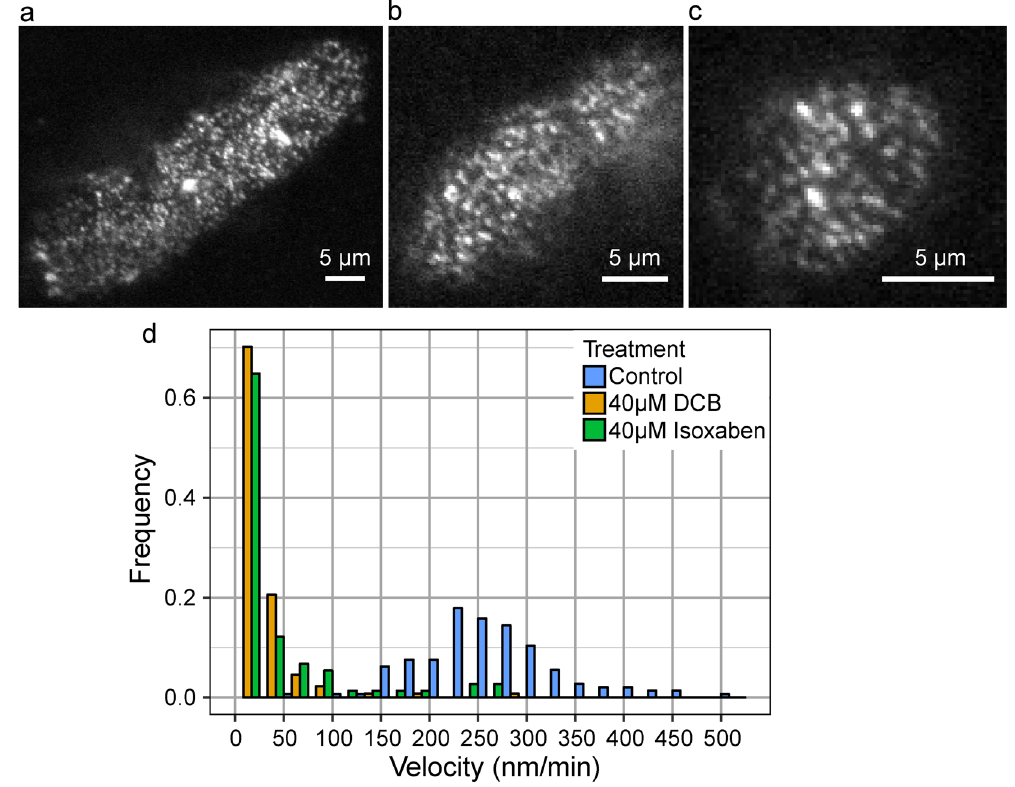
Figure 4. DCB and isoxaben inhibit mEGFP-PpCESA5 particle motility, but do not affect particle density at the cell surface. ( a ) Control protonemal cell treated with 0.1% ethanol. Mean CSC density = 0.48 ± 0.11 particles/ μ m 2 (SD), n = 8 time-lapses. ( b ) Protonemal cell treated with 40 μ M DCB. Mean CSC density = 0.51 ± 0.09 particles/ μ m 2 (SD), n = 8 time-lapses. ( c ) Protonemal cell treated with 40 μ M isoxaben. Mean CSC density = 0.44 ± 0.11 particles/ μ m 2 (SD), n = 8 time-lapses. Scale bars = 5 μ m. ( d ) Velocity distribution of mEGFP-PpCESA5 particles pooled from 24 time lapses. Mean velocities ± standard deviation in nm/min